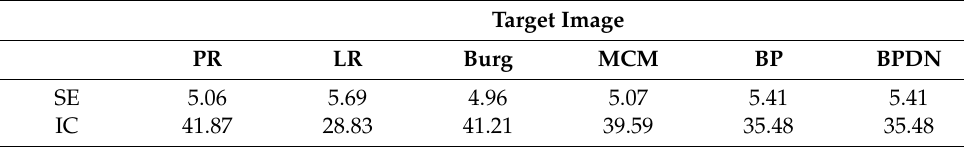
Table 4. SEs and ICs of target images of extended moving